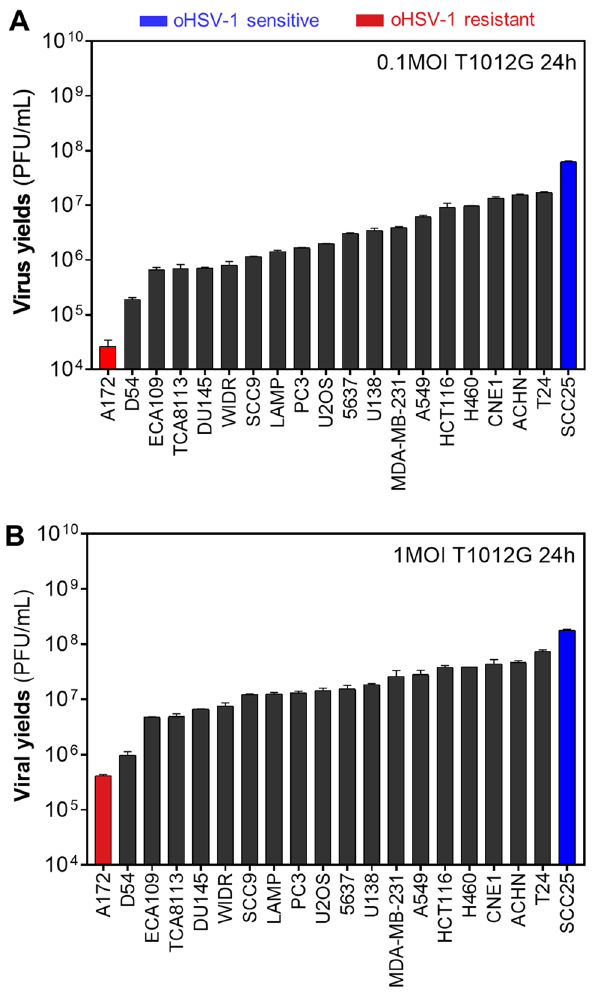
Figure 1. Differential capacity of oHSV-1 T1012G replicating in various human tumor cell lines. ( A , B ) Viral production of oHSV-1 T1012G in various human tumor cell lines. According to the capacity of viral proliferation, human glioblastoma cells A172 were defined as oHSV-1 resistant tumor cells (red marked), human tongue squamous carcinoma cell SCC25 were defined as oHSV-1 sensitive tumor cells (blue